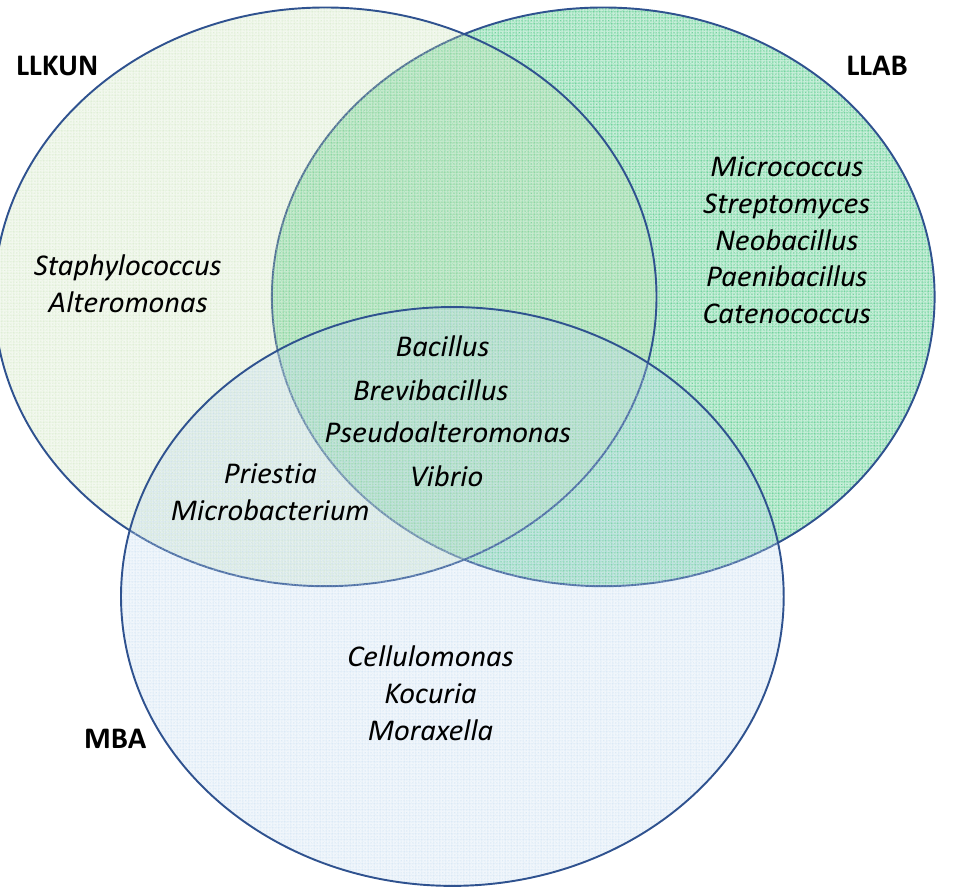
Figure 4. Venn diagram highlighting ( A ) distribution of bacterial general among algal samples with barplots mentioning the total number of unique genera in each sample and ( B ) Identity of unique and shared bacterial genera in Sargassum polycystum sampled from 3 different locations.